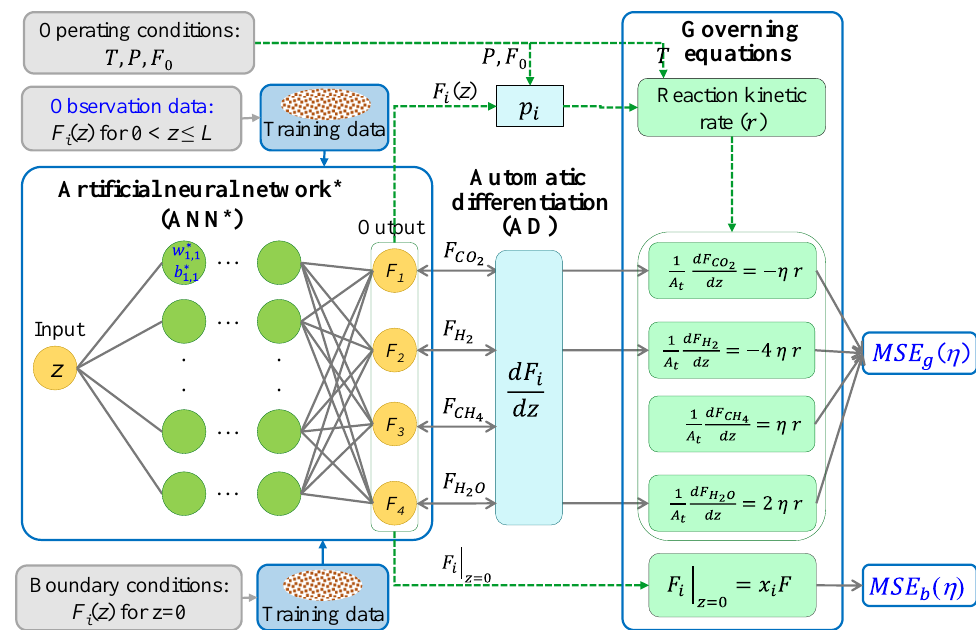
Figure 3. Architecture of the physics-informed neural networks (PINN) inverse problem for CO 2 methanation in an isothermal fixed-bed (IFB) reactor.